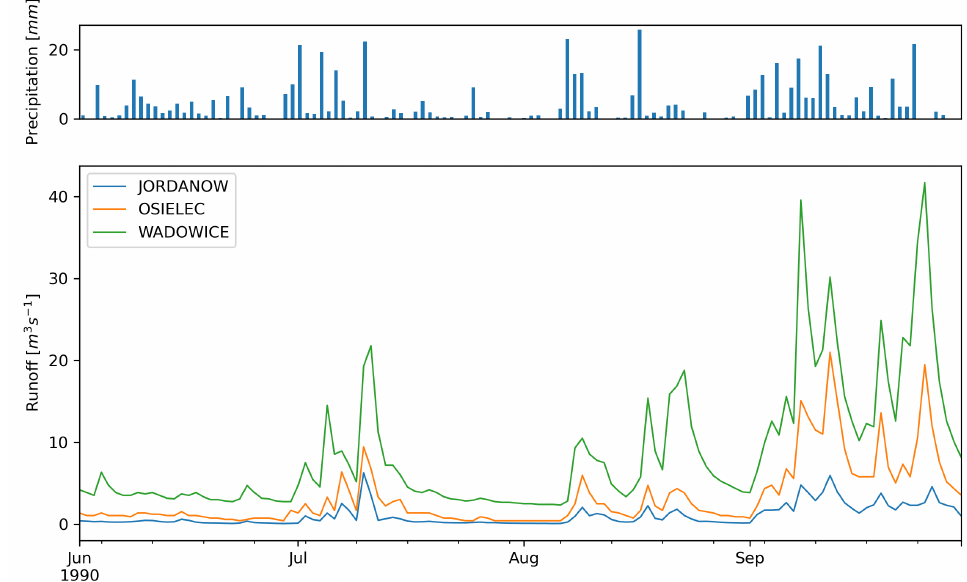
Figure 2. Sample data used in presented research—daily precipitation and daily runoff at three cross-sections of Skawa River in summer